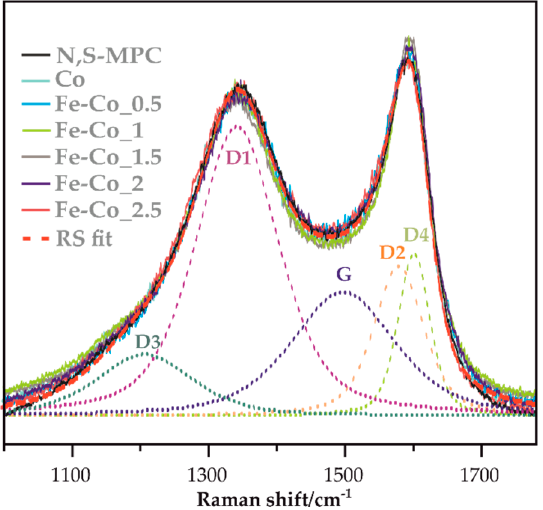
Figure 2. Raman spectra of bare N,S-MPC support and spinel/carbon (indicated in the figure) samples includes deconvolution into individual component signals (dash lines).